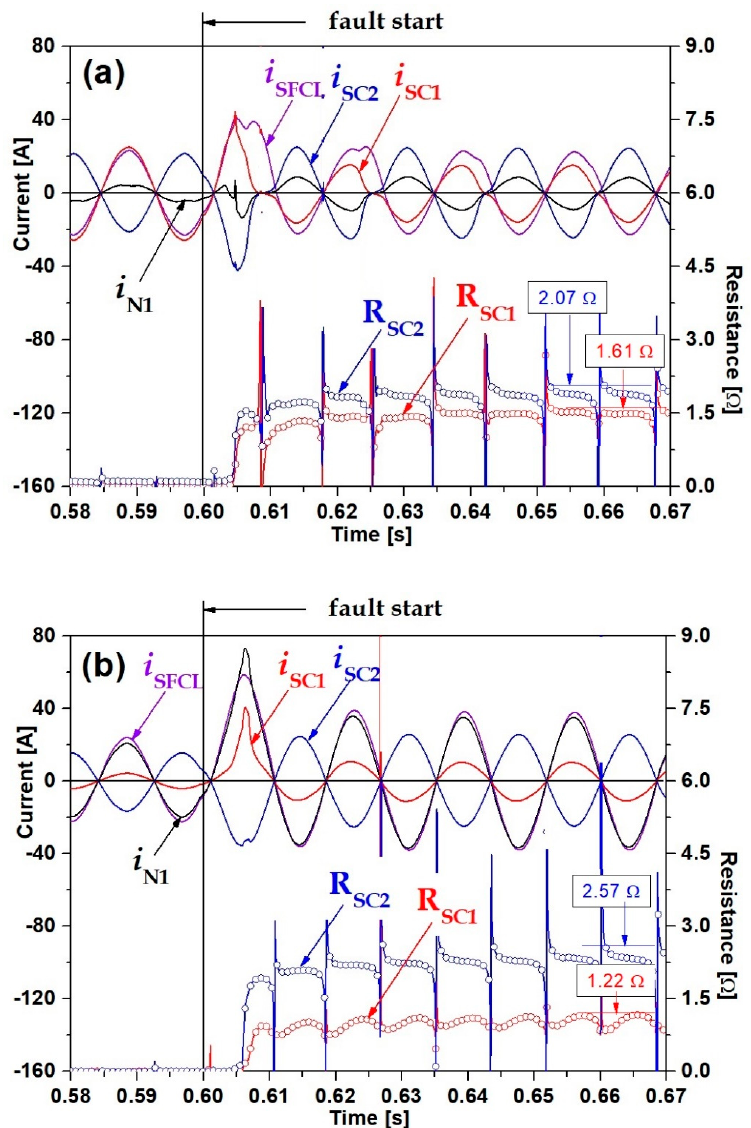
Figure 5. Current and resistance characteristics of the SFCL and two superconducting elements according to the winding direction: ( a ) the reverse winding direction ( b ) the same winding direction.